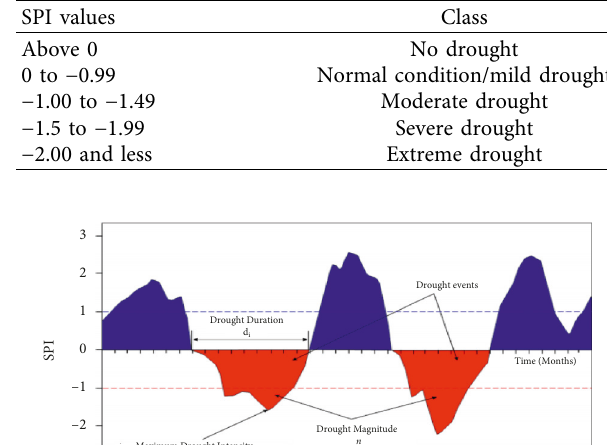
Table 4: Drought categories defined by SPI values.